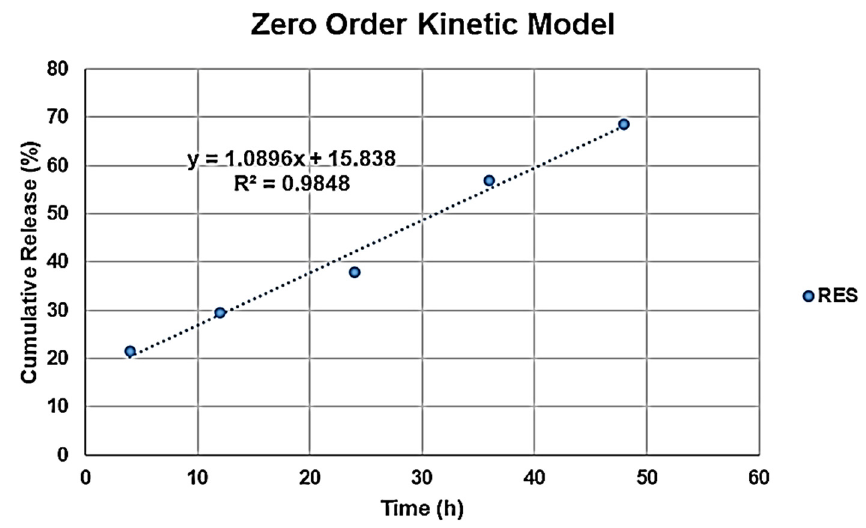
Figure 9. Zero order kinetic mathematical model.